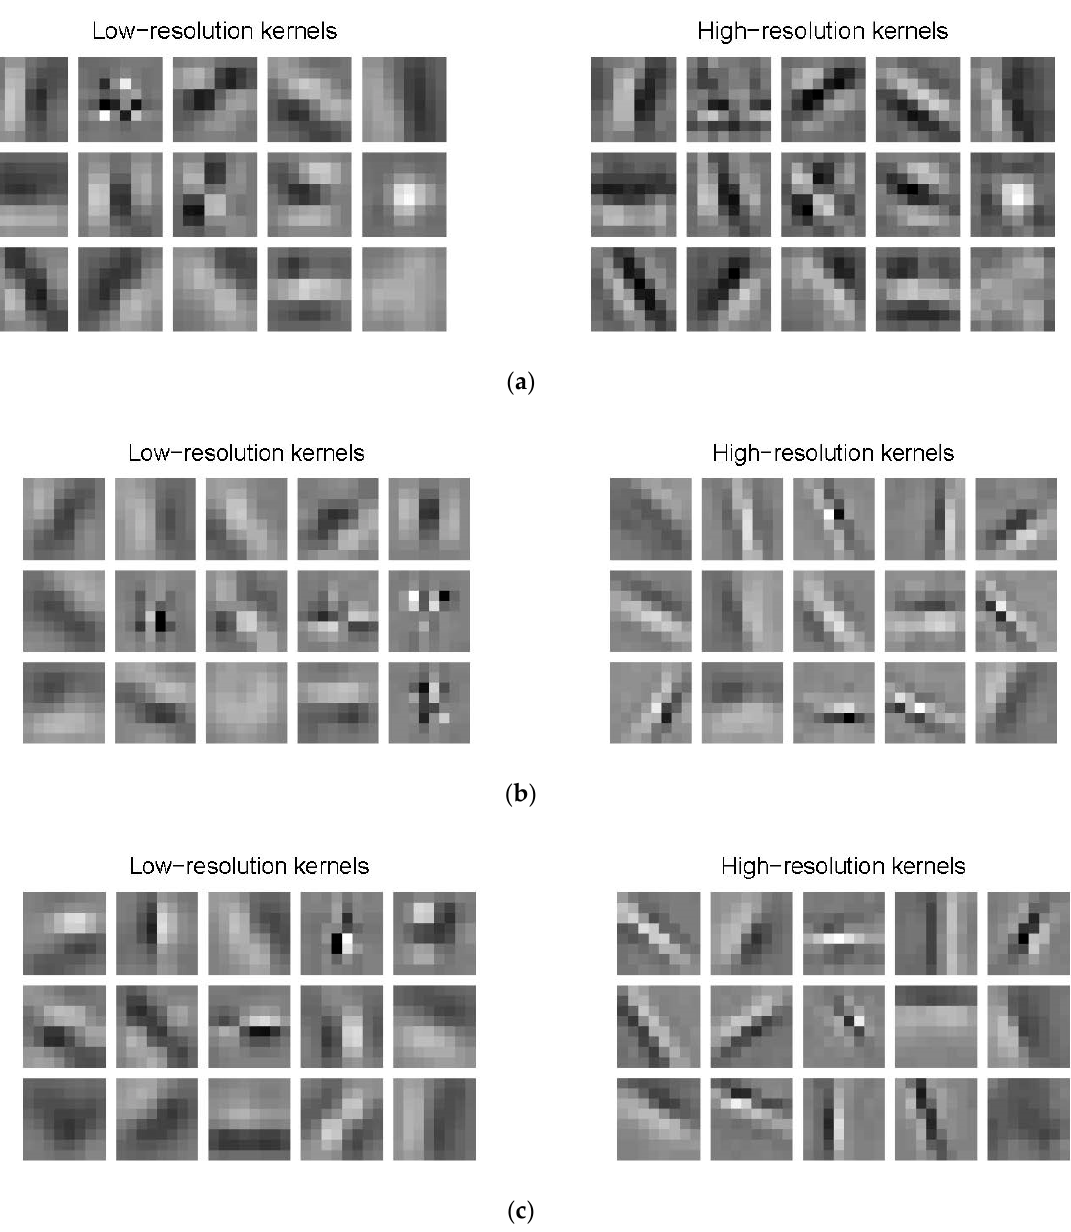
Figure 5. Filters learned by different methods. ( a ) Filters learned by conventional convolutional sparse coding (CSC). ( b ) Filters learned by linear mapping-based convolutional sparse coding (LMCSC). ( c ) Filters learned by semi-coupled convolutional sparse learning (SCCSL).